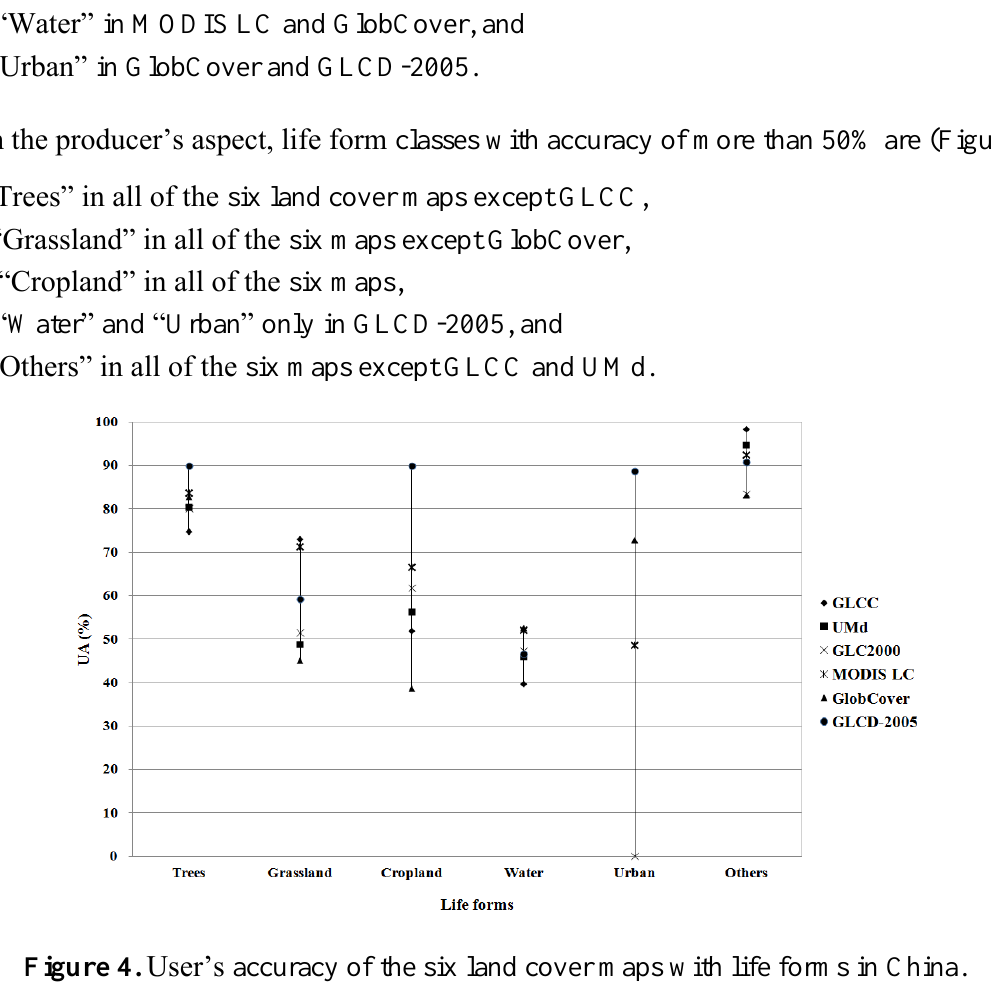
Figure 4. User’s accuracy of the six land cover maps with life forms in China.